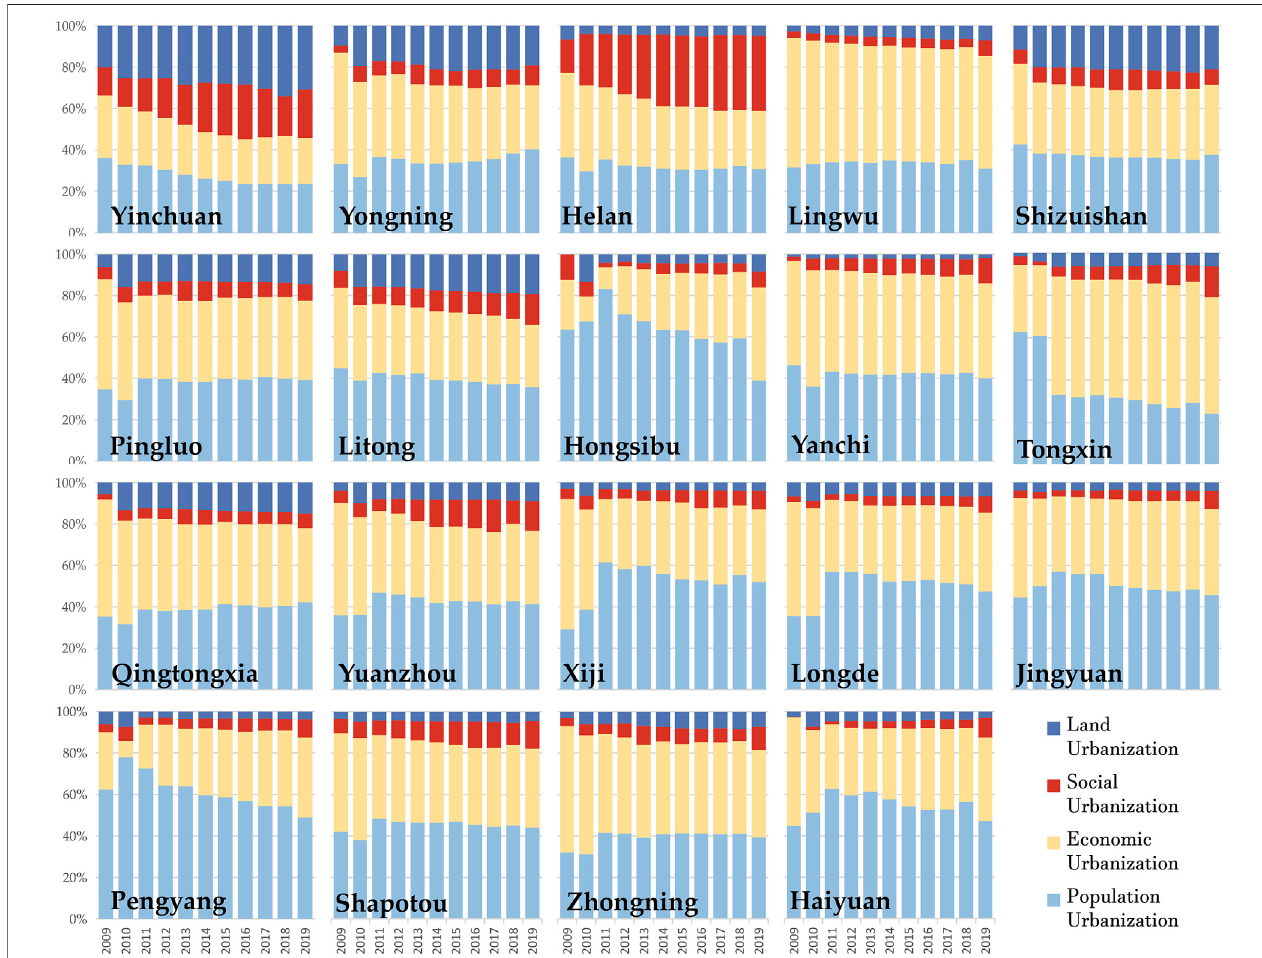
FIGURE 6 | Changes in the proportion of different dimensions of urbanization in Ningxia from 2009 to 2019.